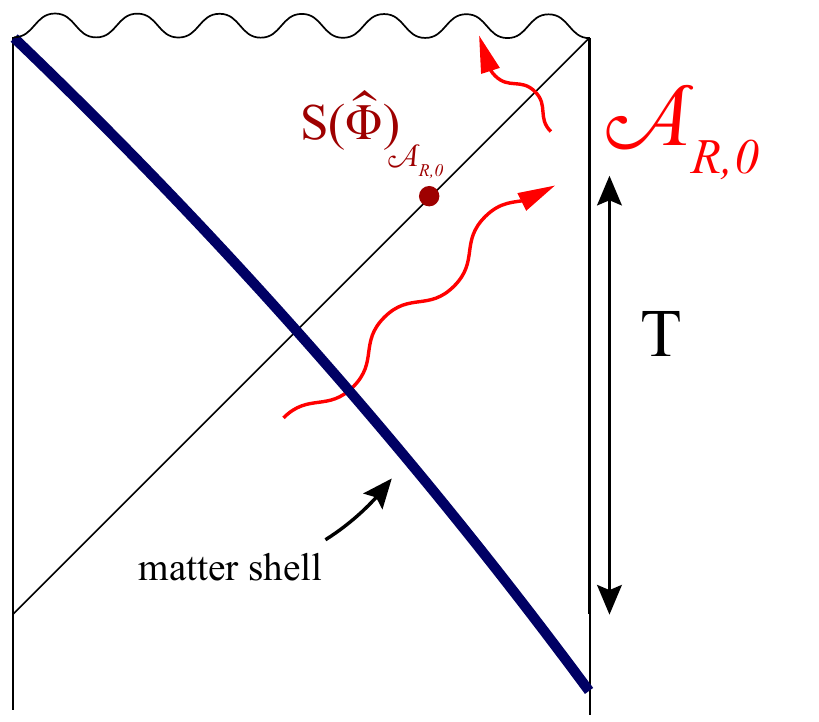
Figure 5 . If a one-sided black hole formed from collapse is allowed to equilibrate for a parametrically long time T , the late time large N algebra A R, 0 is unable to detect that the state is not thermal. It is therefore a Type III algebra, and we can construct a Type II algebra A R as usual by adding the renormalized Hamiltonian h R . The entropy of this algebra is equal to the generalized entropy of the equilibrated black hole horizon before the matter in A R, 0 falls